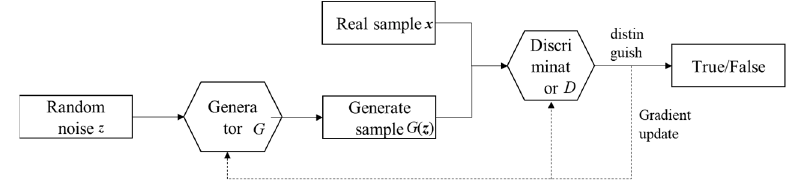
Figure 4. Generative adversarial network architecture.